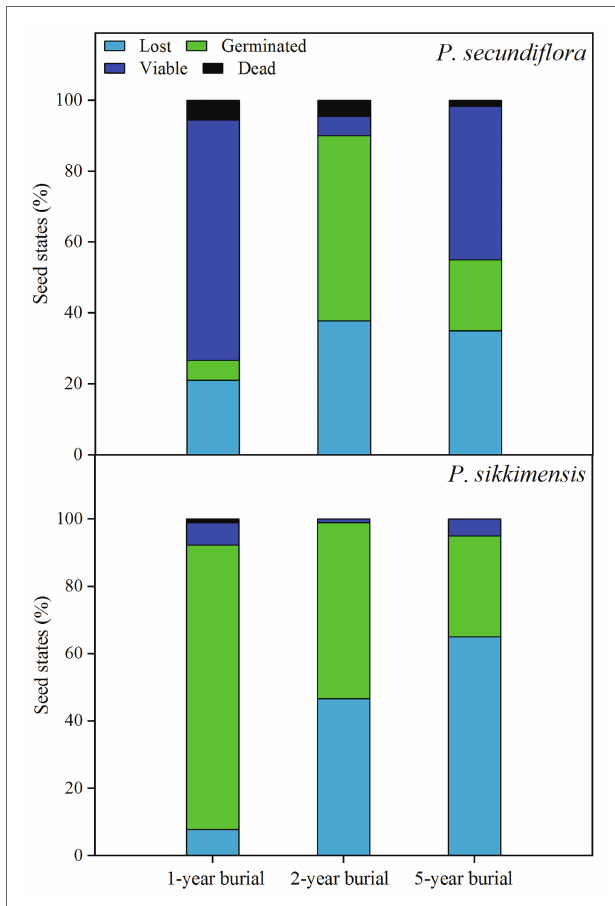
FIGURE 6 | The fraction of lost, germinated, viable, and dead seeds of Primula secundiflora and Primula sikkimensis in the 1st-, 2nd-, and 5th-year after buried. Lost , seed germinated and/or died in the soil whist buried; Germinated , seed germinated after retrieved; Viable , seed did not germinate but could still be stained; Dead , the remaining proportion. The proportion of seeds in each category was calculated for 30 seeds initially put in the replicate seed